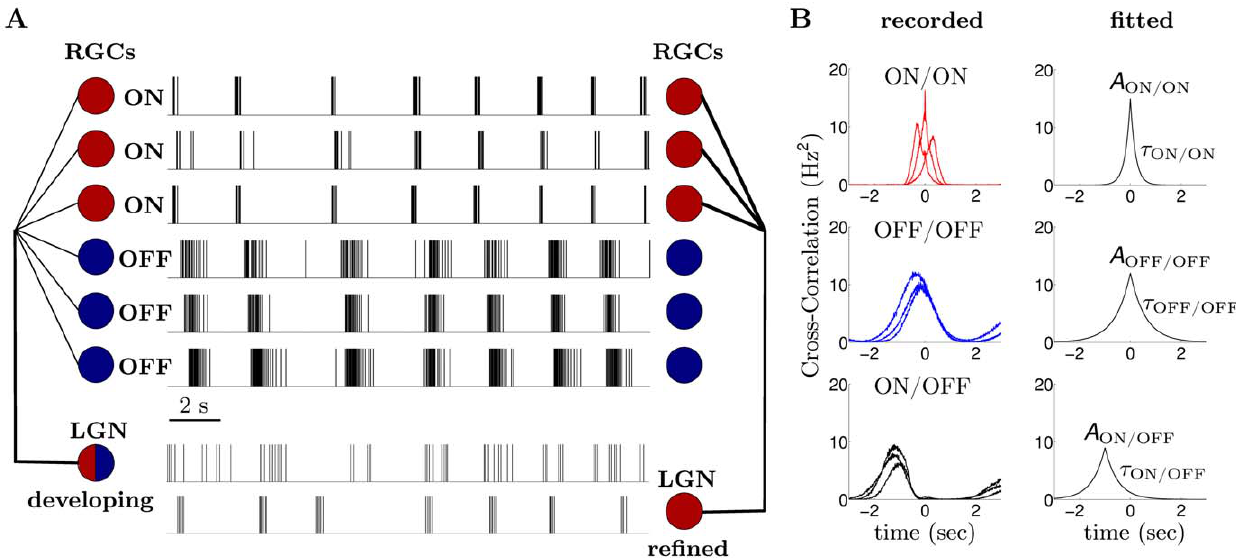
Figure 1. Model description and input correlation functions. (A, left) An LGN neuron receives feedforward weak synaptic input from neighboring ON (red) and OFF (blue) RGC inputs early in development. (A, right) Spontaneous retinal waves selectively refine RGC inputs, such that synaptic weights of one RGC type (ON) strengthen, while weights of the other RGC type (OFF) decay to 0, resulting in an ON-responsive LGN neuron. Sample P12 spike rasters in the middle demonstrate that ON cells fire shorter bursts of higher spike frequency, while OFF cells fire longer bursts of lower spike frequency, * 1 second after ON [20]. Also shown are spike rasters for a developing LGN neuron receiving weak mixed ON and OFF inputs, and for a refined LGN neuron, receiving selective input solely from ON RGCs. LGN spiking activity was generated using the integrate-and-fire model in Equations 12–13. (B) Correlation functions for the input spike trains shown in (A) (mouse data set 1). The input correlation function for RGCs of the same type (ON/ON and OFF/OFF) peaks at * 0 seconds, while for RGCs of different type peaks at * { 1 second for ON/OFF and * z 1 second for OFF/ON pairs. Symmetric decaying exponentials were fit to the pairwise input correlations using Equation 11. Peak amplitudes and decay time constants for pairs with maximal peaks are reported in Table 1. doi:10.1371/journal.pcbi.1000618.g001 bottom panel). We explored segregation outcome as a function of integrals of STDP, A { t { = A z t z (Figure 2A). Most experimental the balance between depression and potentiation effects in the data have reported similar integration timescales for depression plasticity rule, denoted by the ratio of the negative and positive and potentiation, and approximately equal amplitudes [30], or Table 1. Peak amplitudes and decay time constants of the symmetric fall-off exponential fits to the correlation functions of the most-correlated input pair from spontaneous retinal wave recordings by Kerschensteiner and Wong [20] (values given as estimate + standard error). S S ON = ON T ( t ) and S S OFF = OFF T ( t ) denote the average firing rates of the two most correlated ON and OFF cells in each data set; other parameters are illustrated in Figure 1B.